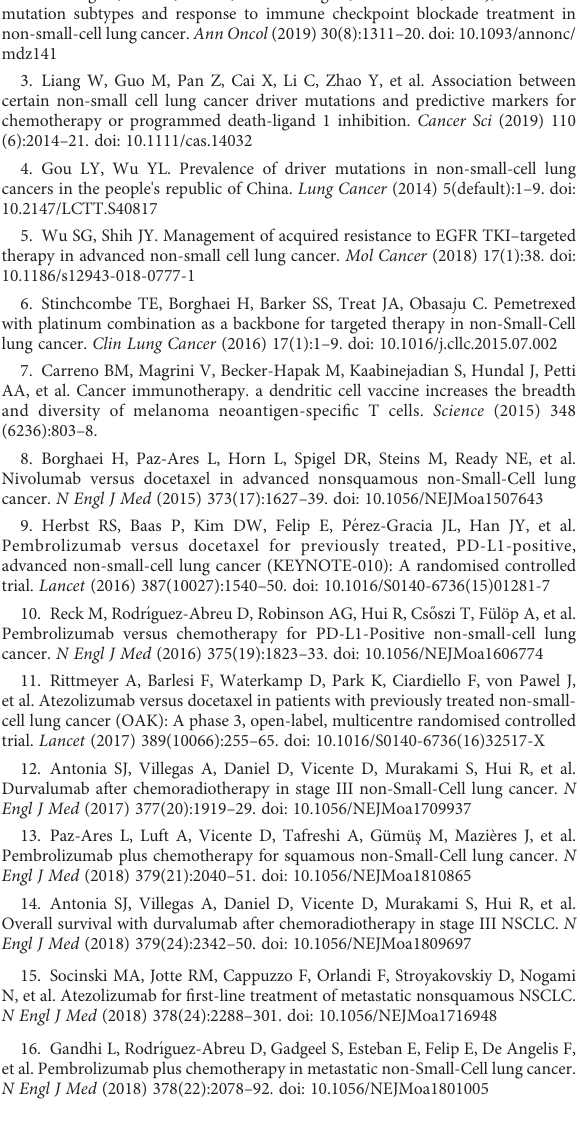
SUPPLEMENTARY FIGURE 1 The rarefaction curve shows the selected population was not biased towards certain allele